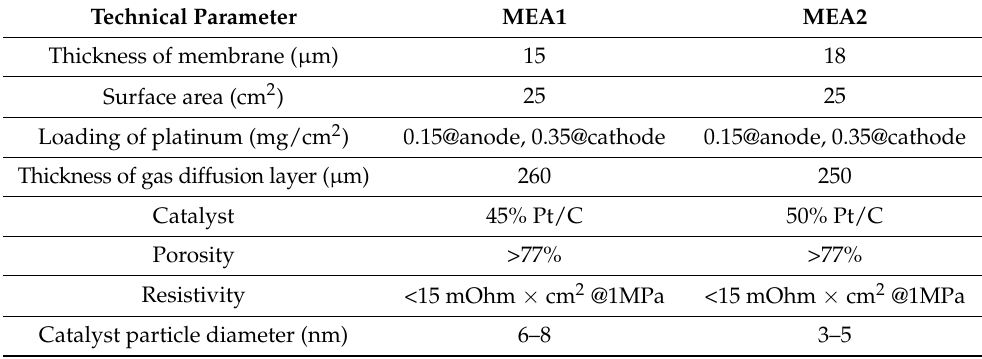
Table 1. Technical parameters of two membrane electrode assemblies (MEAs) used in the PEMFC.